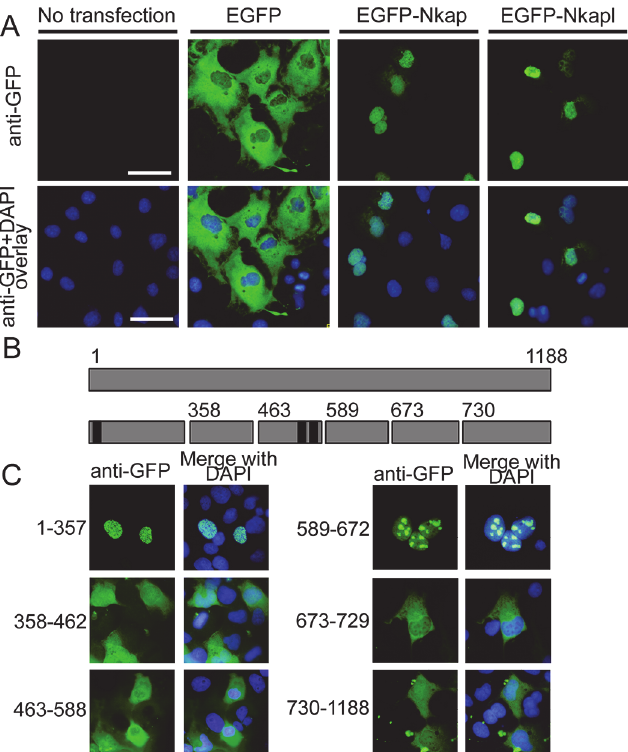
Fig 2. Nuclear localization signal (NLS) analyses of NKAPL in vitro . (A) Immunofluorescence with GFP antibody after transfection of EGFP-tagged vectors into 293T cells. Upper row shows images of GFP expression, and lower row shows those merged with DAPI staining to visualize nuclei. White scale bars = 50 μ m. (B) The upper bar represents the open reading frame (ORF) of the Nkapl gene, and the lower bars illustrate the fragmented sequences of the Nkapl gene, which were inserted into EGFP-tagged vectors. Numbers over the bars indicate the fragmented sites on the ORF. Black regions indicate the sequence including the putative NLS signal amino acids predicted by cNLS Mapper prediction program. (C) Immunofluorescence of GFP antibody after the transfection of EGFP-tagged fragmented Nkapl . Left columns show the immunofluorescent images with GFP antibody, and the right columns show those merged with DAPI staining.